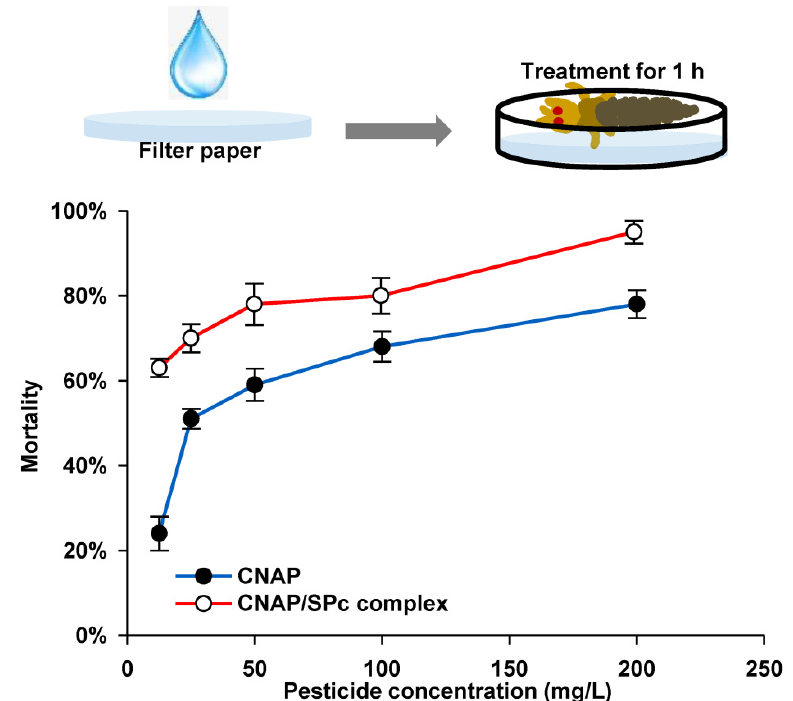
Figure 4. Toxicity of CNAP/SPc complex against 2nd instar nymphs of WFT at 48 h after the treatment. n = 10. Table 3. Toxicity of CNAP and CNAP/SPc complex against 2nd instar nymphs of WFT at 24 h after the treatment.